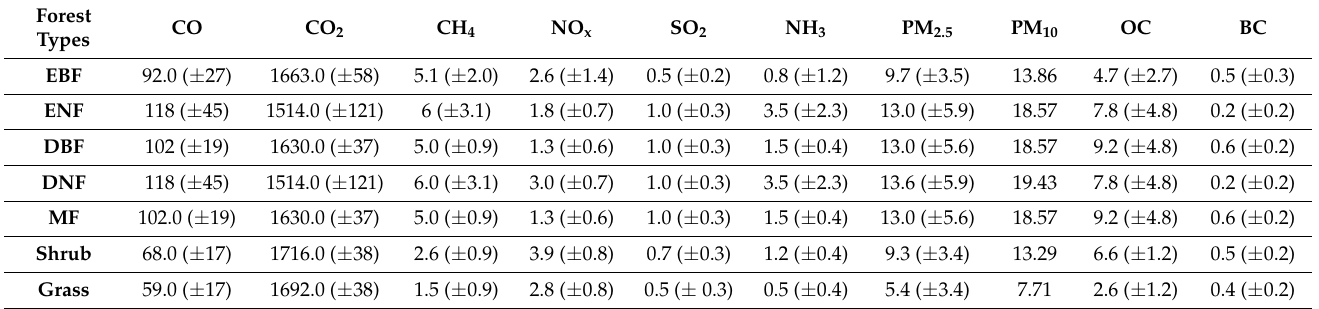
Table 2. Emissions factors (EFs; g kg − 1 ) and uncertainties of pollutants (gases and aerosols) by different forest